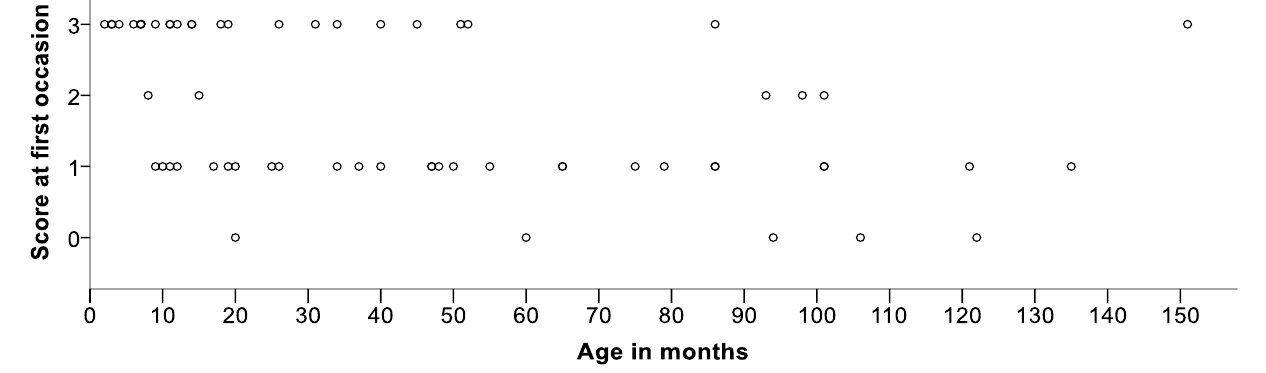
Figure 5. The cats’ scores received on the first occasion of the habituation test based on their age.